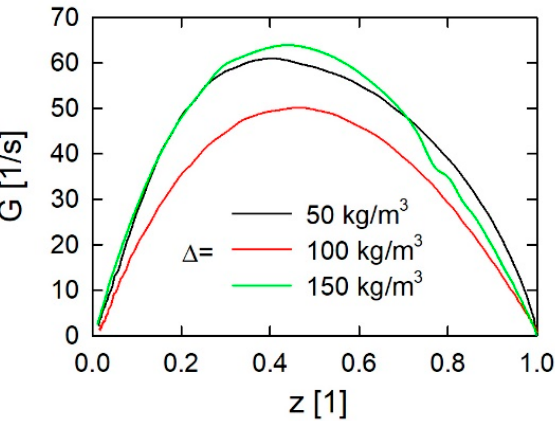
Figure 15. G ( z ) plots obtained for black powder (recalculated from [15]).